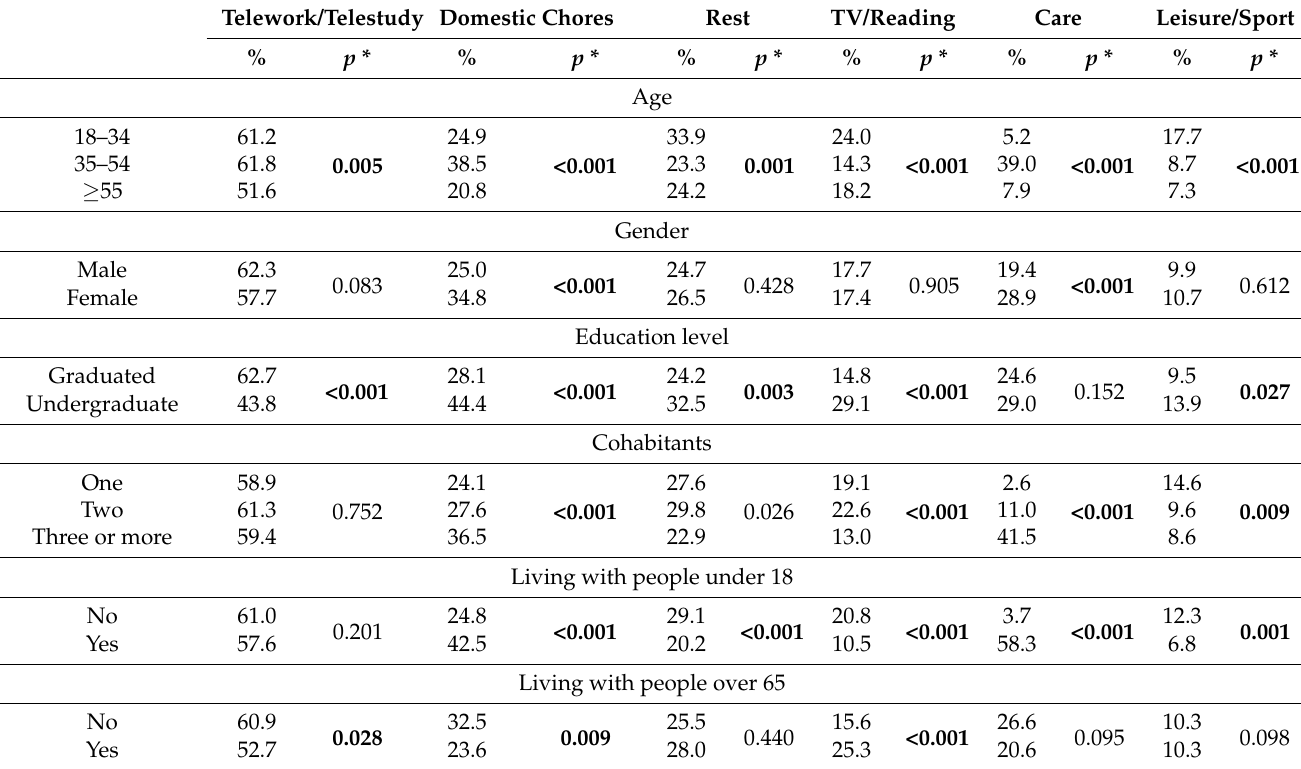
Table 3. High dedication to tasks in confinement according to socio-demographic and coexistence characteristics. Telework/Telestudy Domestic Chores